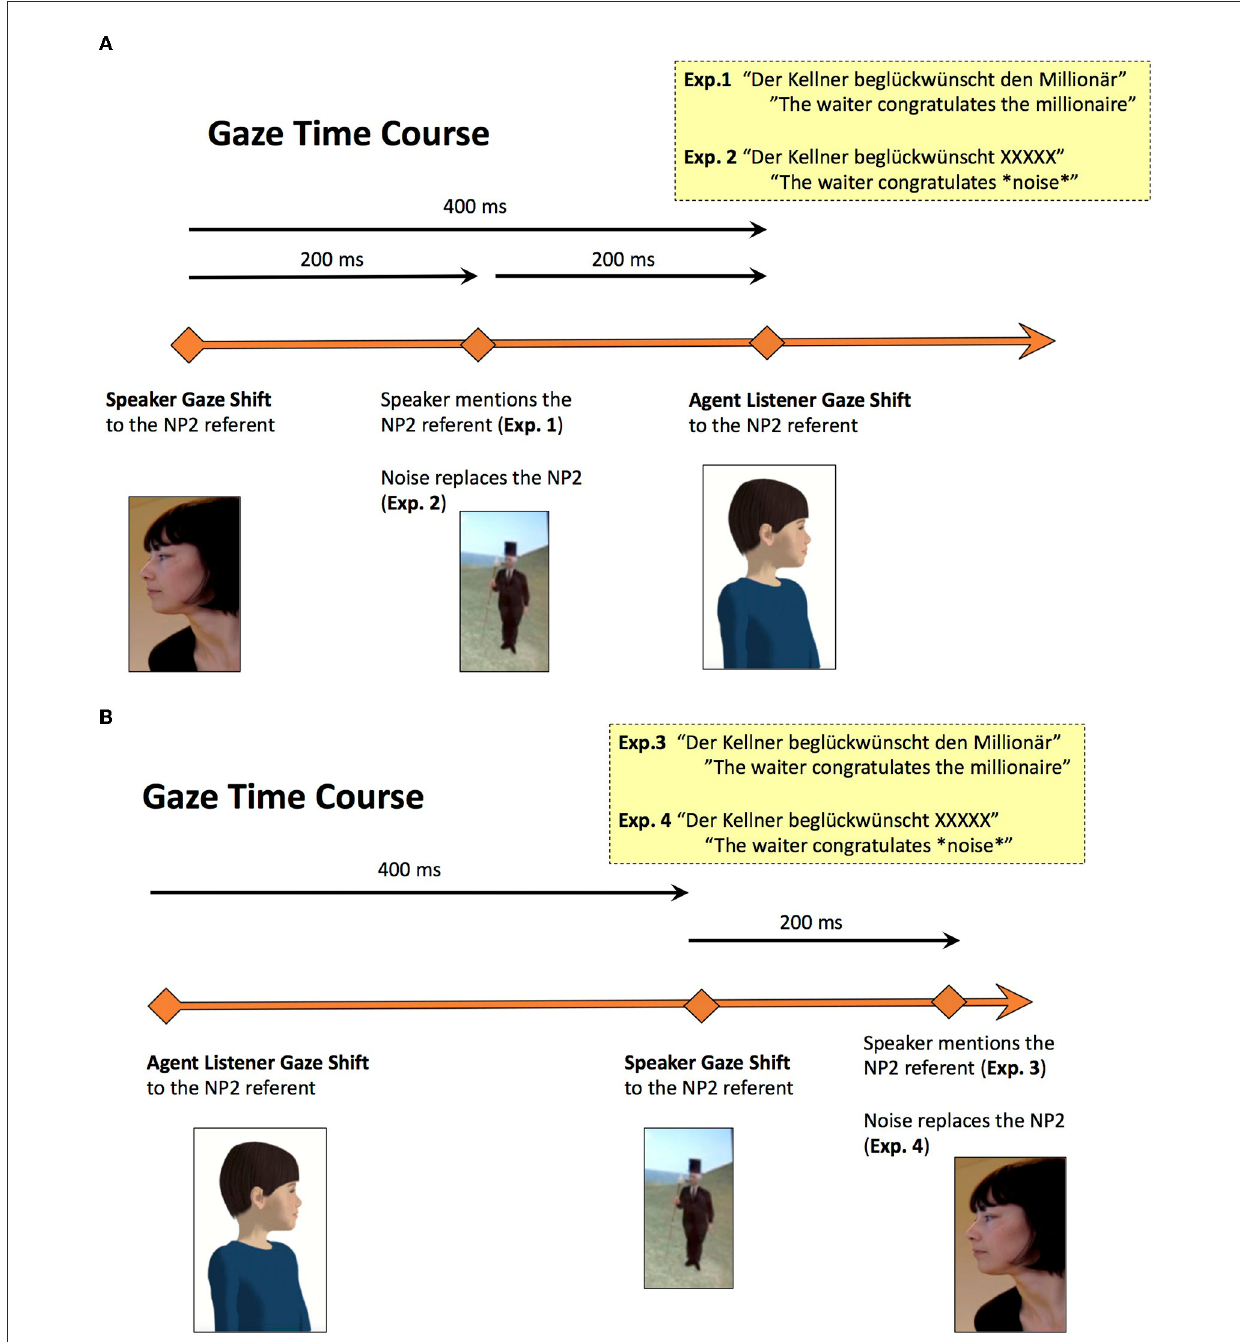
FIGURE2 Display of the human speaker and agent listener gaze time course. Speaker Gaze Shift and Agent Listener Gaze Shift mark the points when the interlocutors first fixated the NP2 referent (A) Experiments 1 and 2. Adapted from Nunnemann (2021, p. 68). (B) Experiments 3 and 4. Adapted from Nunnemann (2021, p.